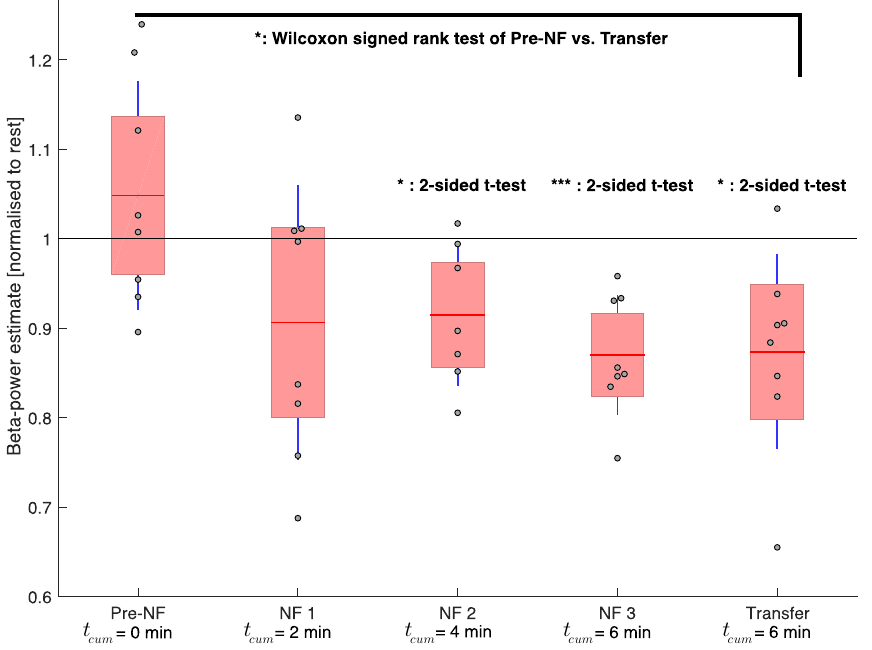
Figure 2. Learning to downregulate beta activity with DBS-neurofeedback. Beta-power estimates from all patients during downregulation—normalised to the beta-power estimate during each patients’ preceding rest block—are shown for the baseline (pre-NF), neurofeedback (NF1, NF2, NF3) and transfer rounds. We indicate the cumulative amount of time t cum that patients have spent learning downregulation through neurofeedback until the end of that respective round. The group means are represented by the horizontal red lines, the standard deviations by the vertical blue lines and the 95% confidence intervals by the red patched areas. We used the two- sided Student’s t -tests to test for significant beta-reductions compared to the baseline rest (horizontal black line at 1). Wilcoxon’s signed rank test was used to compare the dependent samples from the transfer round with their pre-NF value. *p < 0.05; ***p < 0.001.